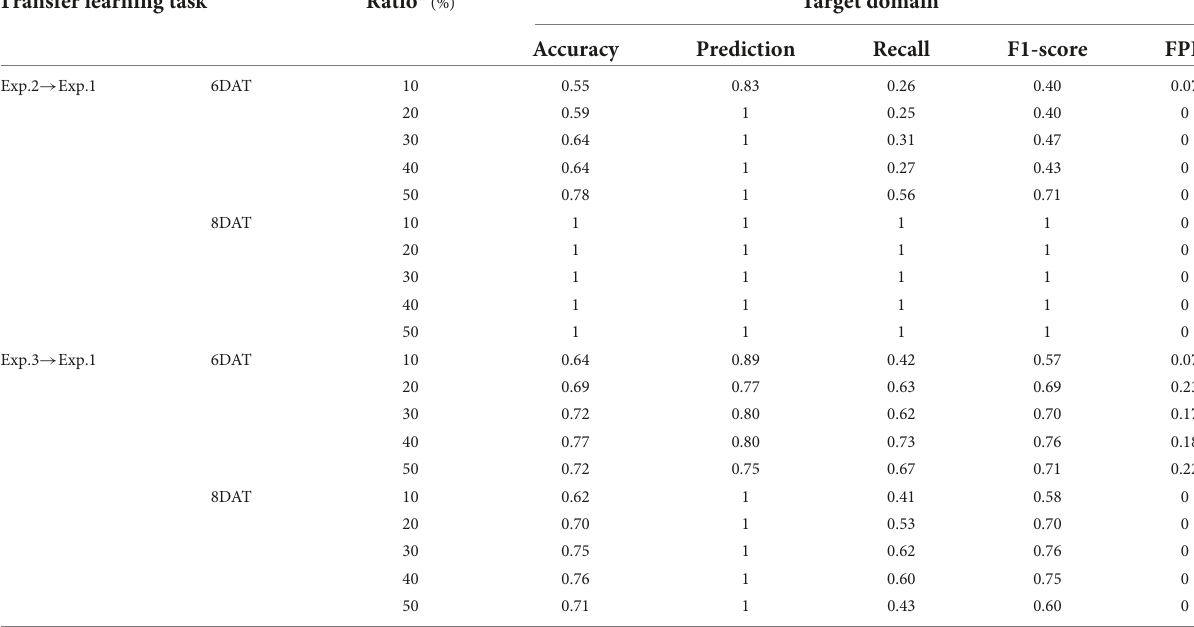
TABLE 4 Prediction results of source domain updating-based support vector machine models on target domain. Transfer learning